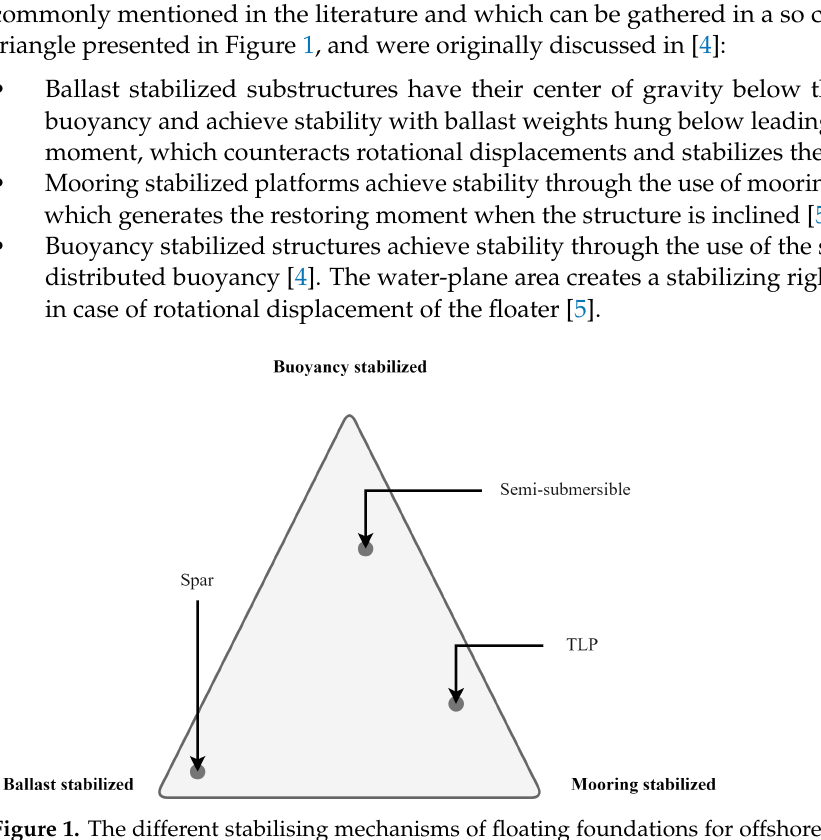
Figure 1. The different stabilising mechanisms of floating foundations for offshore wind turbines, adapted from